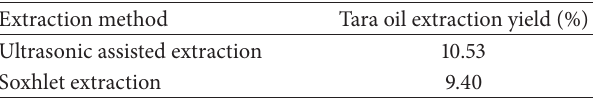
Table 2: Percentage yield of tara seed oil. Extraction method